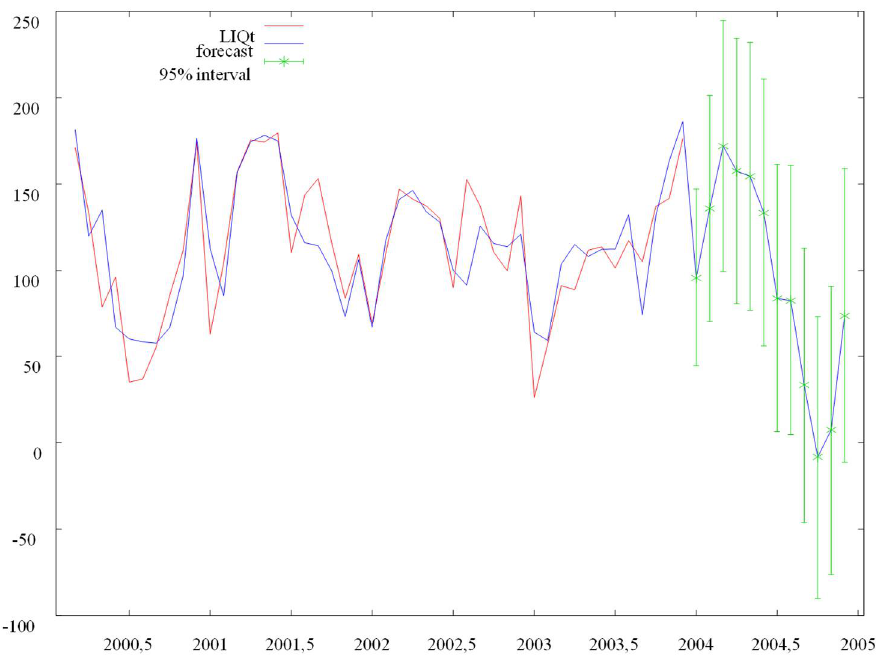
Figure 1. Convergent monthly forecasts of the company’s financial liquidity (LIQ Tp ) for the year 2004. Source: own calculations using the GRETL package.